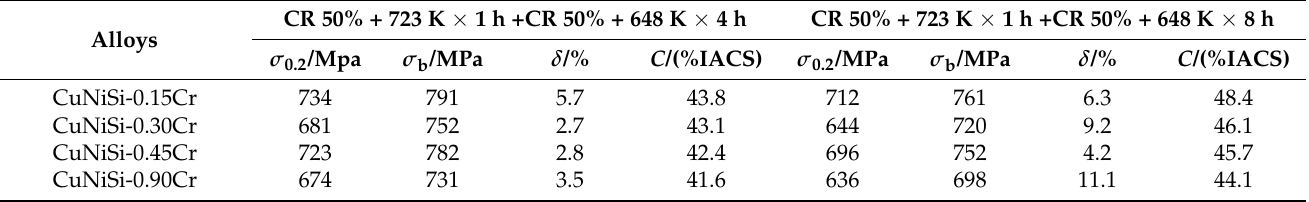
Table 3. Tensile properties and electrical conductivity of designed CuNiSiCr alloys.